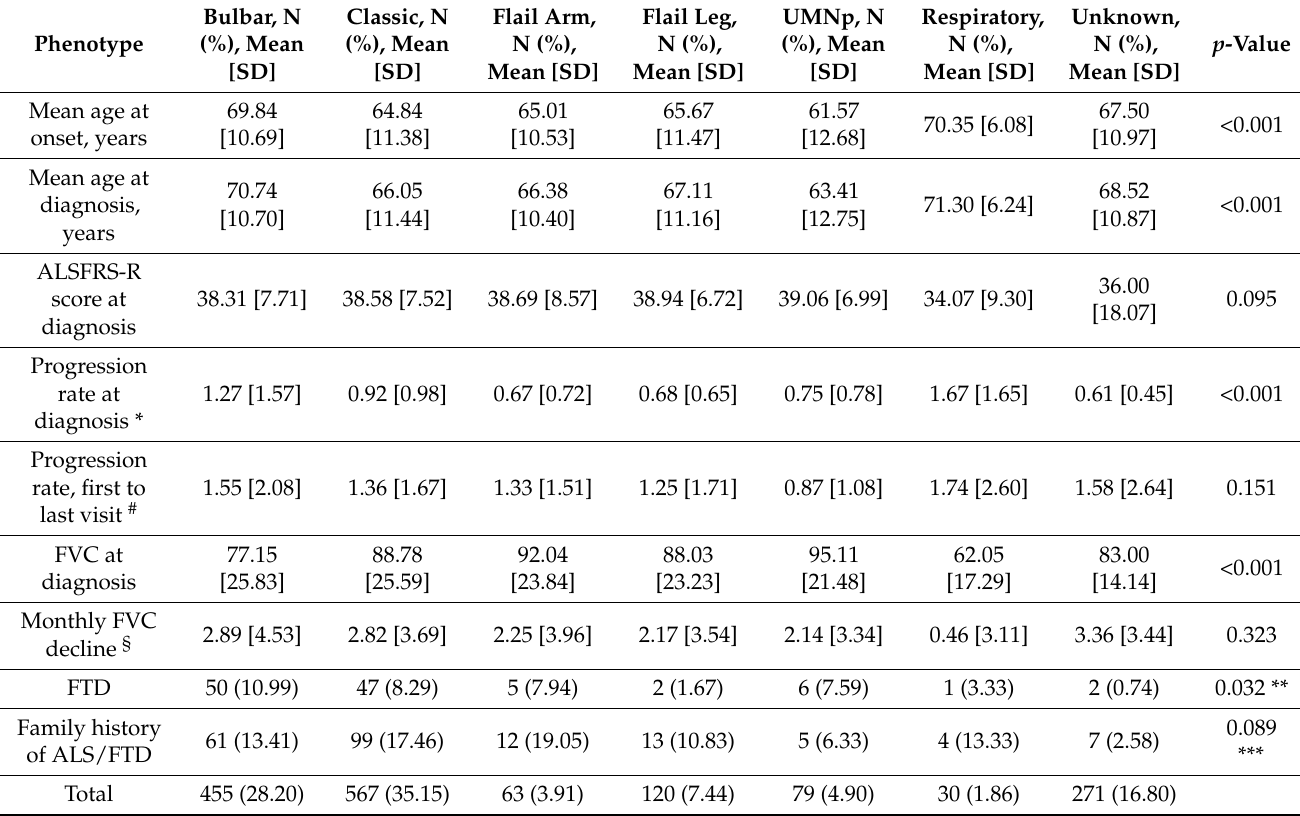
Table 2. Characteristics of patients according to